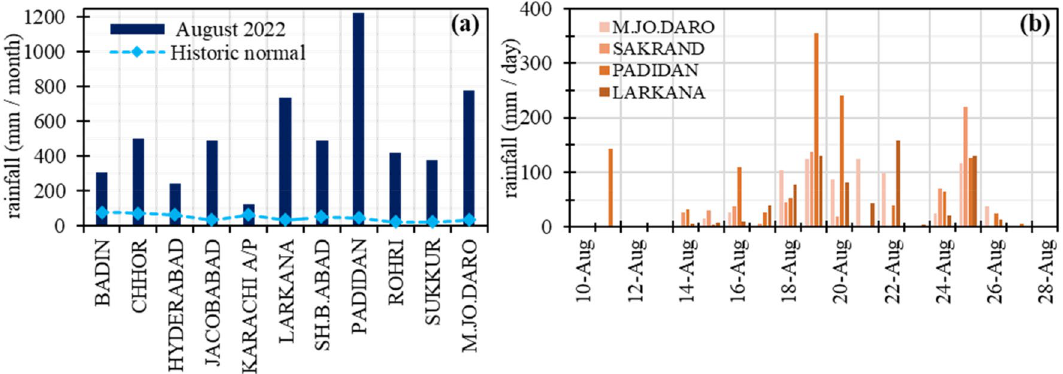
Figure 3. Station-based records of rainfall during August ( a ) Monthly average rainfall across different weather stations in Sindh during August 2022 and historic average in August (1981–2010), ( b ) daily rainfall patterns during August 2022 recorded in corresponding districts across Sindh. Source: Pakistan Meteorological Department (PMD).